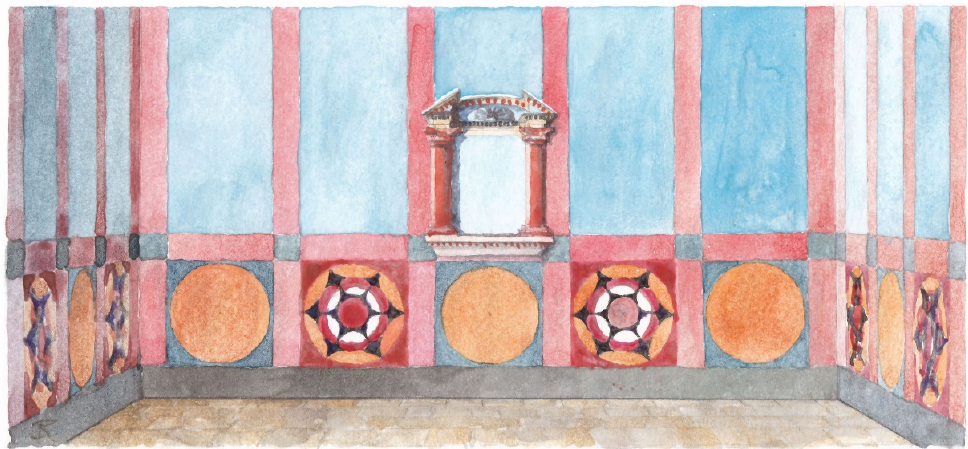
Figure 9. An attempt at a partial reconstruction of the interior decoration of the oikos of house H9 (compiled by Rafał Czerner).